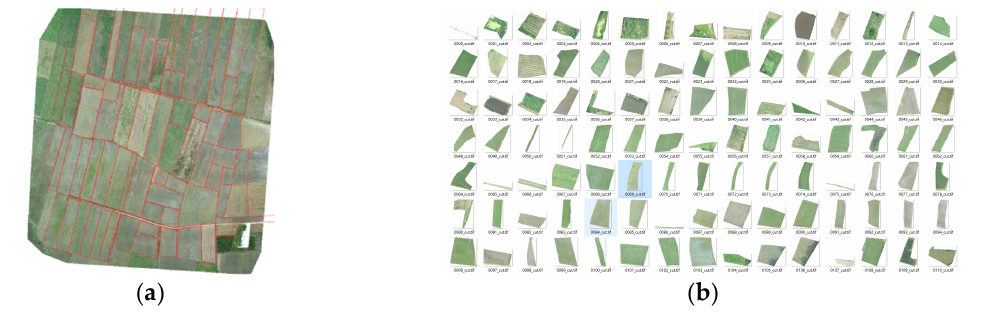
Figure 6. The original image matched with the vector data and then generated as block images for each field block. ( a ) The original image of the village matched with the vector data; ( b ) parts of the block images for each field block.